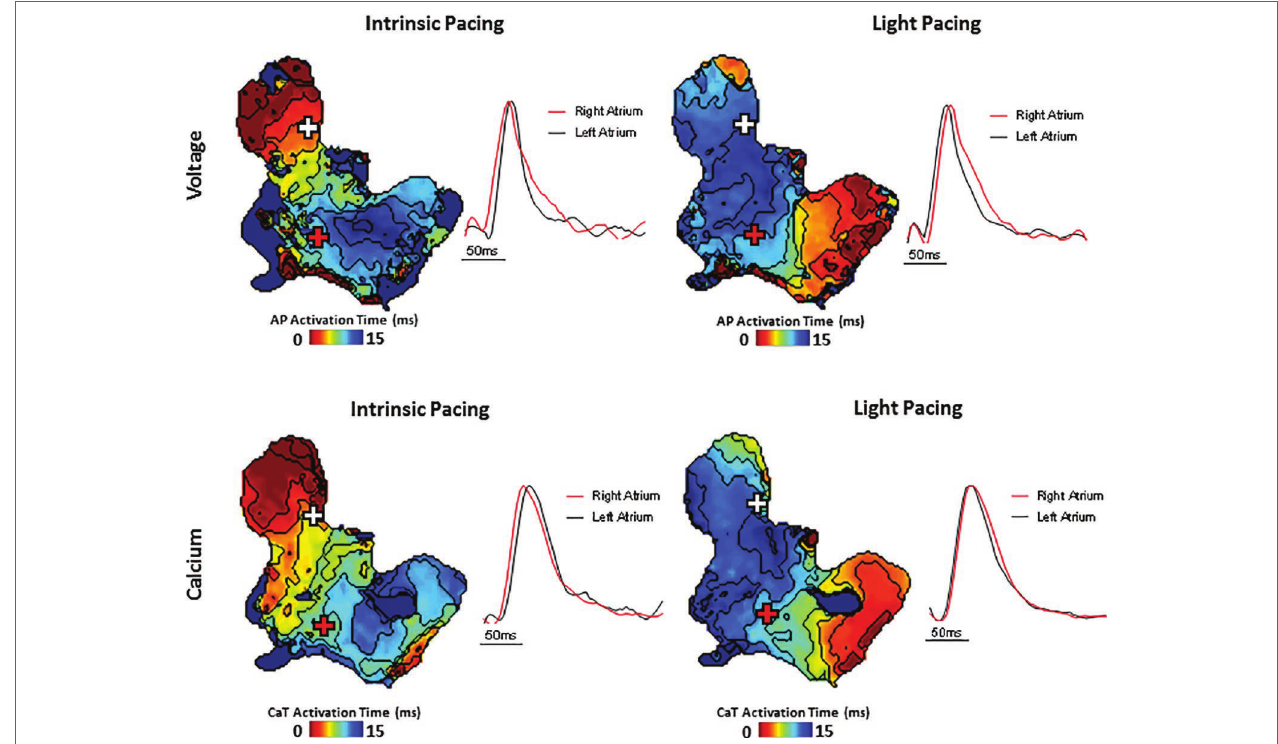
FIGURE 4 | Simultaneous voltage (top panels) and Ca 2+ transient (bottom panels) activation maps reconstructed from spontaneous sinus rhythmic (left panels) and light paced (right panels) SAP. Maps were produced by mapping the midpoint time of the voltage and CaT rise with examples of voltage and Ca 2+ transient traces from indicated regions of the preparation (white and red